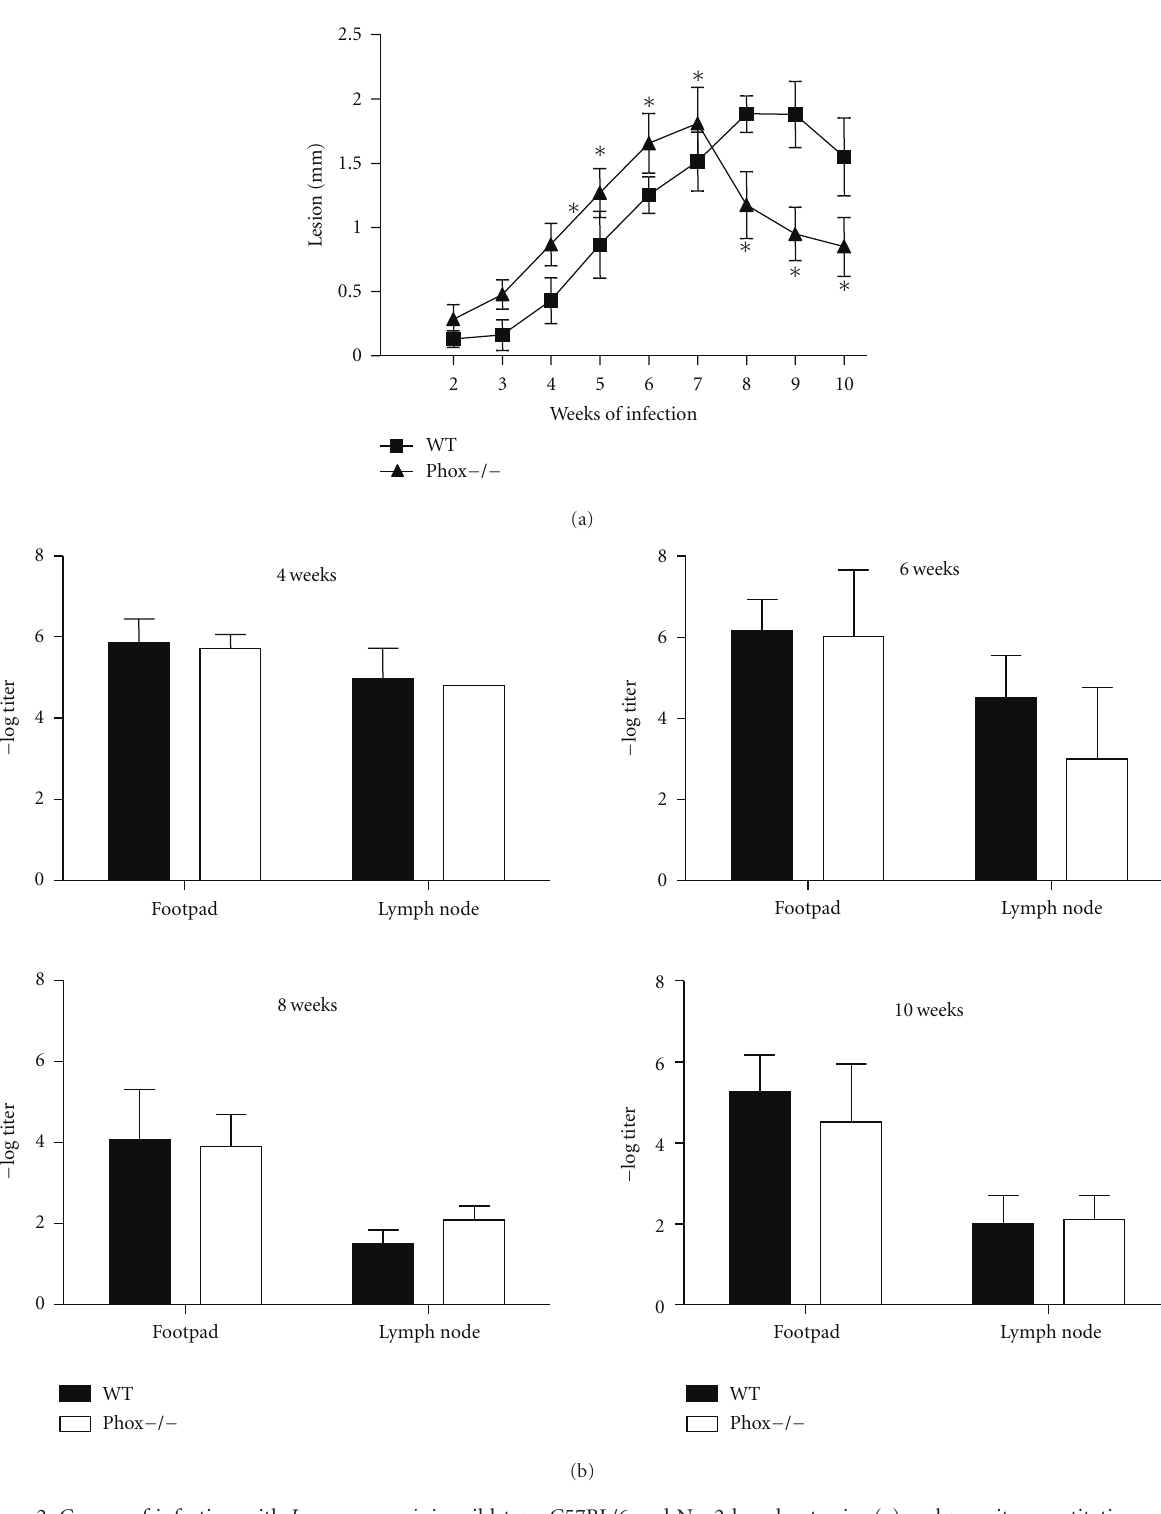
Figure 2: Course of infection with L. amazonensis in wild-type C57BL/6 and Nox2 knockout mice (a) and parasite quantitation using a limiting dilution analysis (b). ∗ indicates statistical di ff erence by Student’s t test, P < 0 . 05 (E. H. Roma and J. P. Macedo,